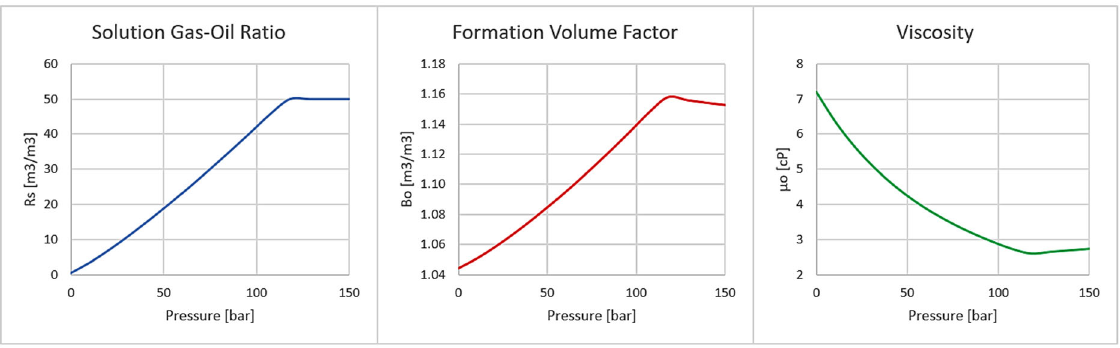
Figure 3. Porosity and permeability variations throughout the reservoir. Using Standing’s black oil correlations [18], the reservoir oil properties as a function of pressure at the reservoir temperature were calculated and are presented in Figure 4 and used to develop the model in the Eclipse simulator.